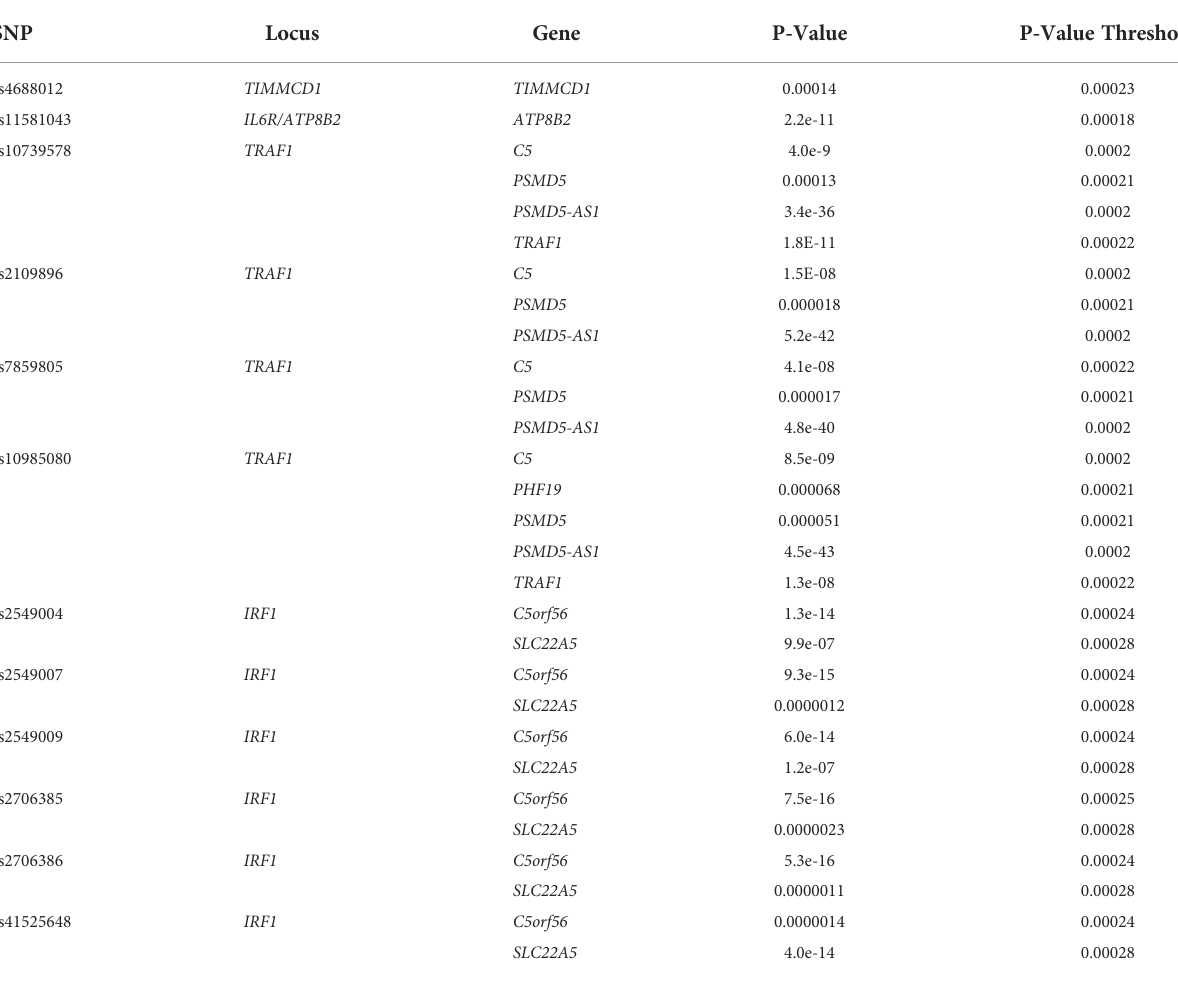
TABLE 7 eQTL SNPs Within Monocyte GROseq Peaks.